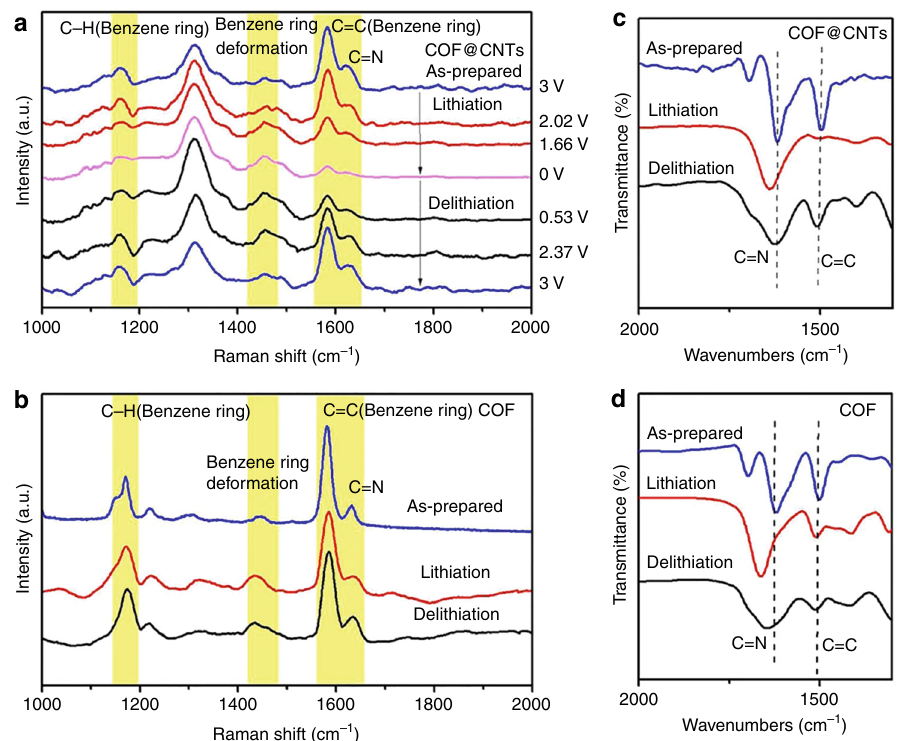
Fig. 4 Structural evolution characterization of COF@CNTs and COF anodes. a Raman spectra of as-prepared COF@CNTs and COF@CNTs anode during lithiation (discharge) and delithiation (charge) process. b Raman spectra of as-prepared COF and COF anode during lithiation and delithiation process. c FTIR characterizations of the as-prepared COF@CNTs and COF@CNTs anode during lithiation and delithiation process. d FTIR characterizations of the